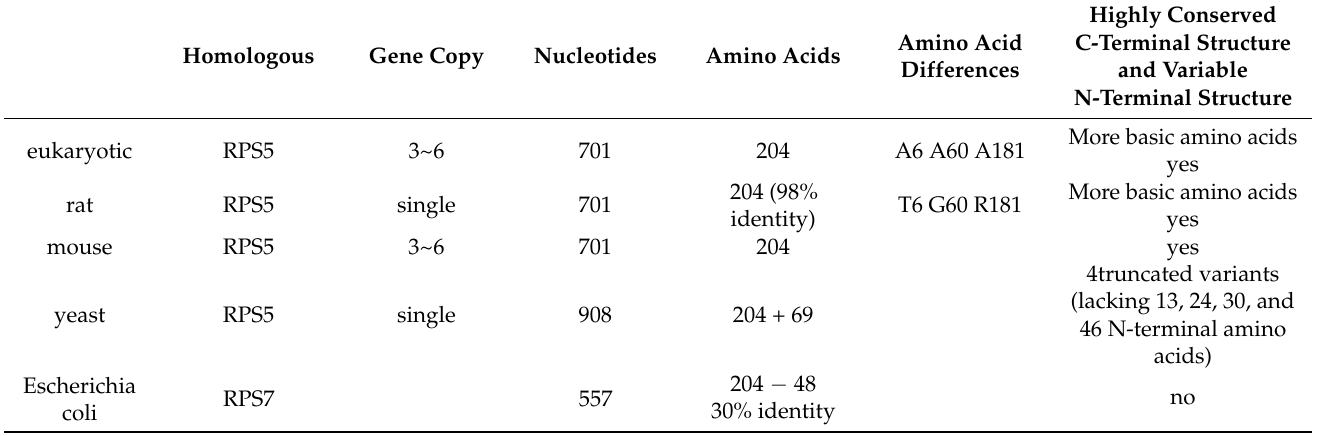
Table 1. A sequence alignment produced by ClustalX of Homo sapiens, Rattus rattus, Mus musculus, Podocoryna carnea, and Saccharomyces